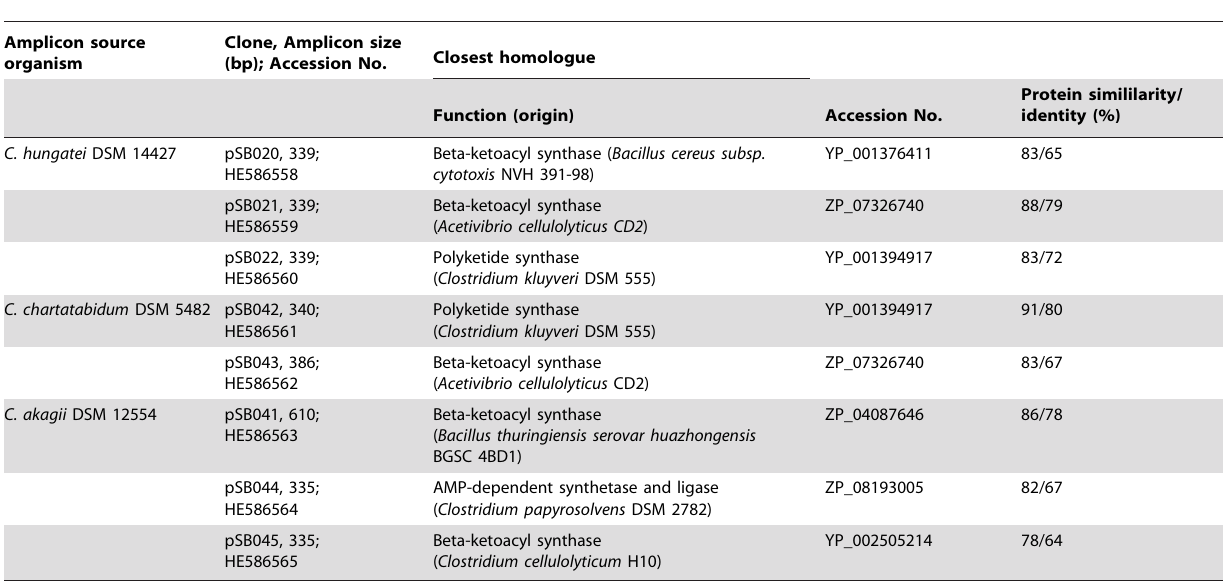
Table 2. BLASTX results of sequences amplified from not yet sequenced Clostridium species genomic DNA using KS domain specific degenerated